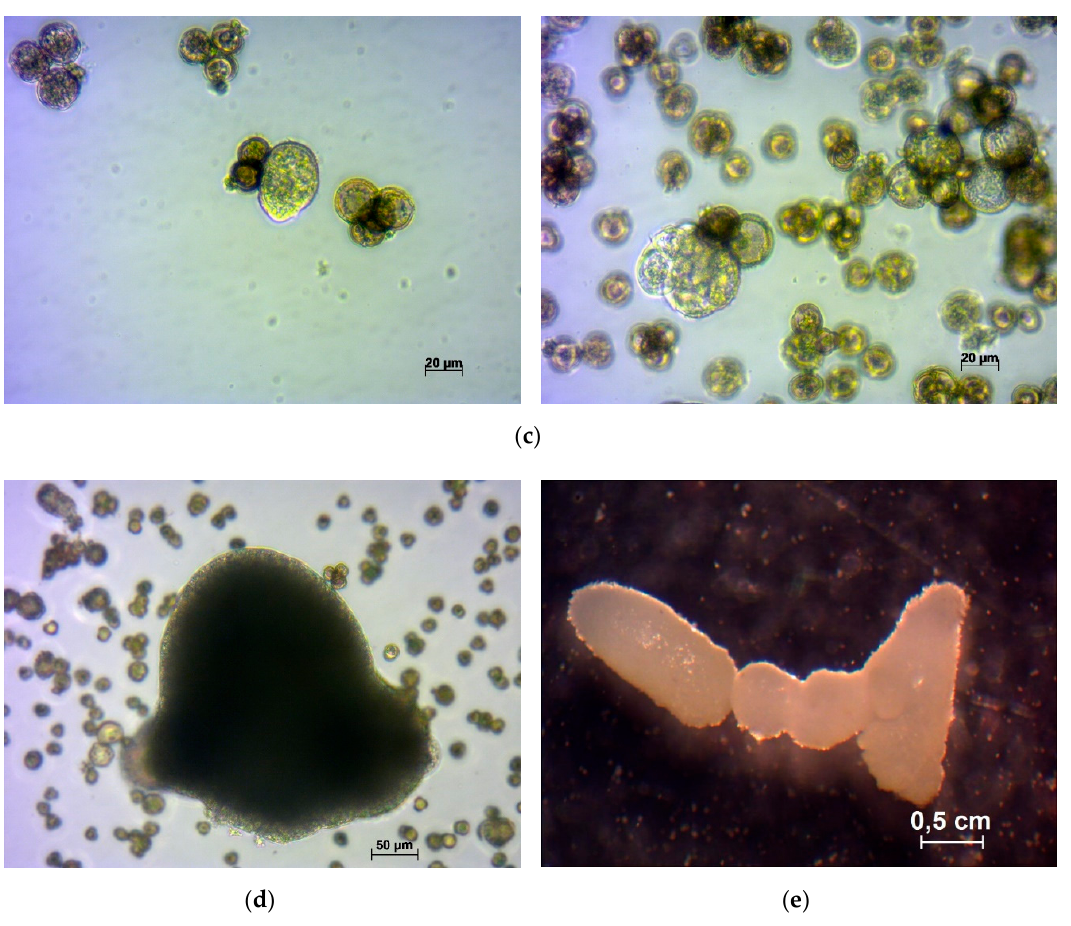
Figure 2. Development of microspores of turnip variety ‘Ronde witte roodkop herfst’ in the in vitro culture: ( a ) Microspores at the beginning of incubation; ( b ) microspores at day 3 of incubation; ( c ) development of microspores at day 7 of incubation; ( d ) turnip embryo developed from microspores, day 14 of incubation; and ( e ) fused turnip embryos developed from microspores (possibly non-separated ones), day 21 of incubation.